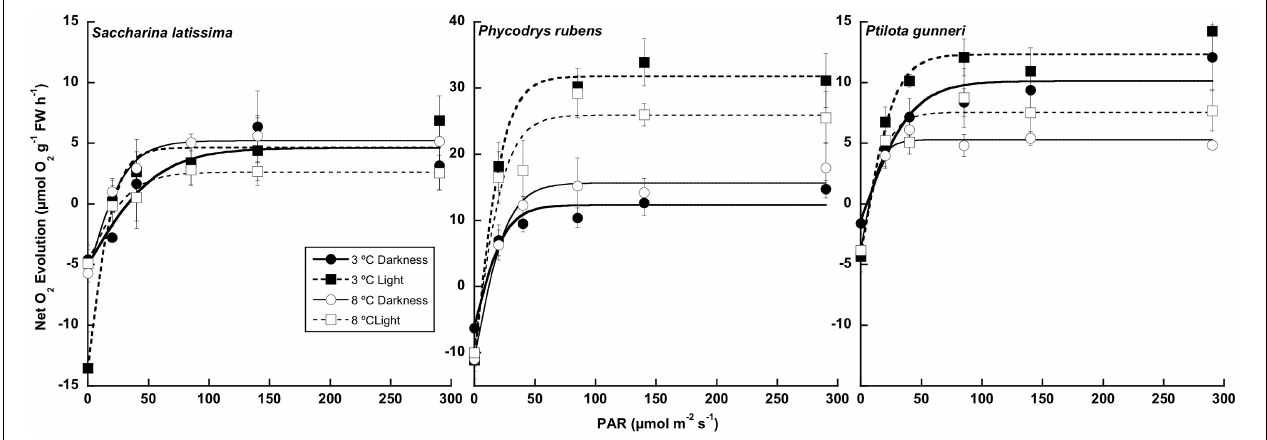
FIGURE 5 | Net photosynthetic rate measured as O 2 consumption at the end of the 16 weeks of incubation in darkness (Darkness), and 1 week after the onset of a photoperiod (Light) of Saccharina latissima , Phycodrys rubens , and Ptilota gunneri at two different temperatures. Data are mean of 3 replicates (error bars for standard deviation). TABLE 2 | Parameters from P-I curves fittings according to Jassby and Platt (1976) measured at the end of the dark period (darkness) and 7 days after light exposure at increasing photoperiod (light).